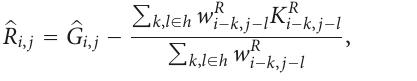
to determine edge directions in the pattern edge